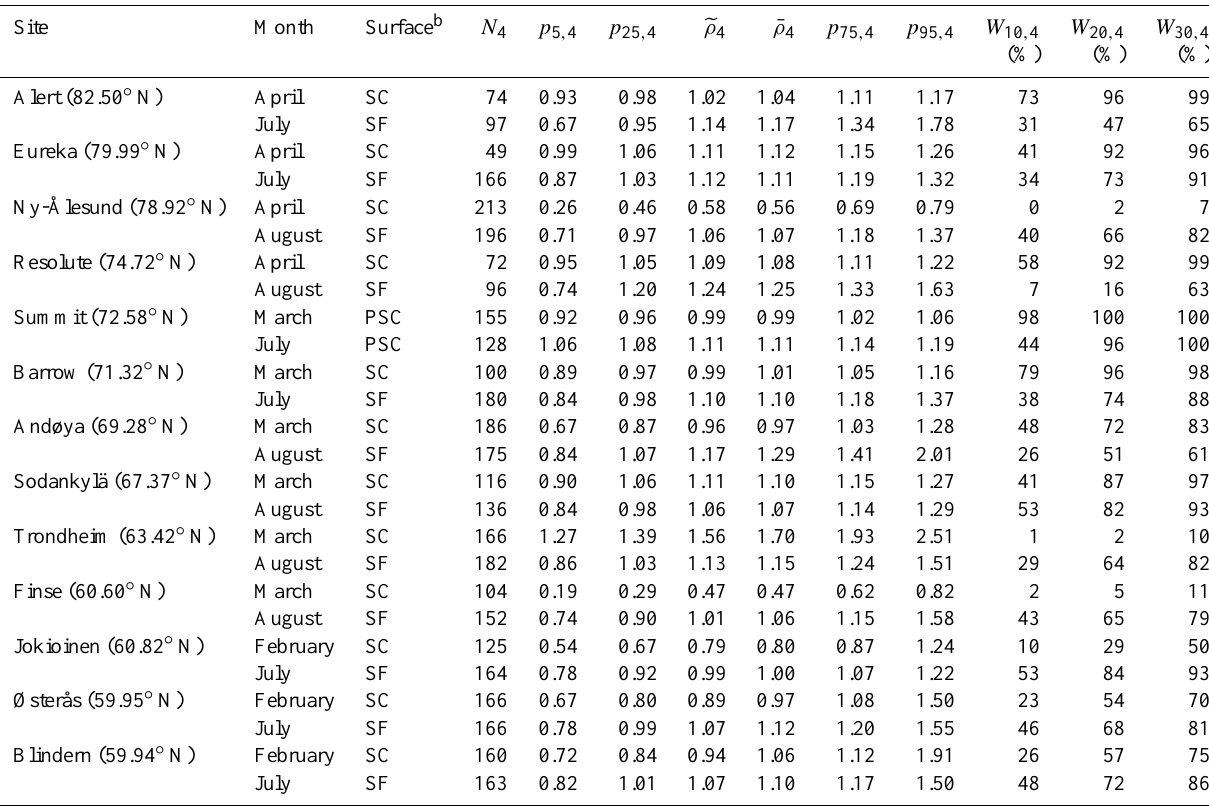
Table 2. Validation statistics a for daily erythemal dose (DP